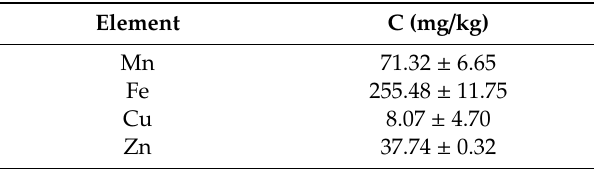
Table 4. Contents of selected metals in E. purpurea aerial